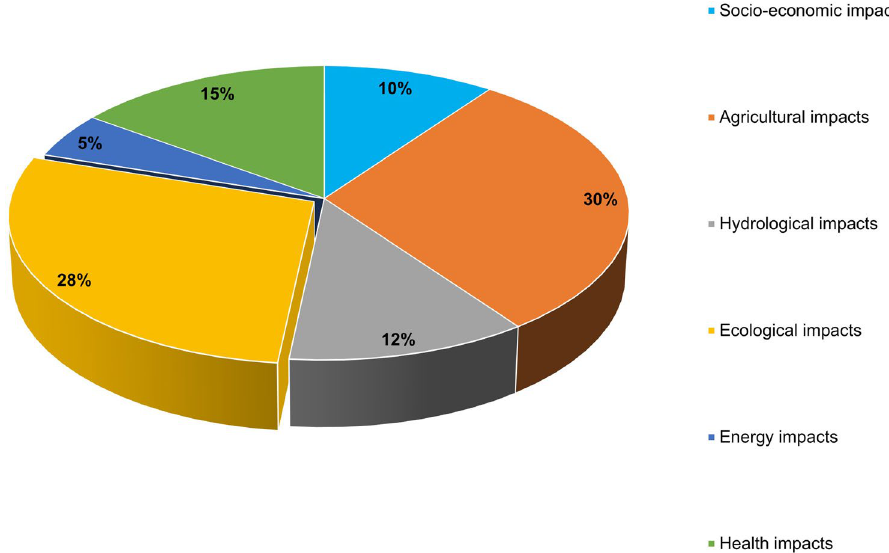
NB, Eight (8) of the studies marked with an asterisk (*) fall within at least two categories considering